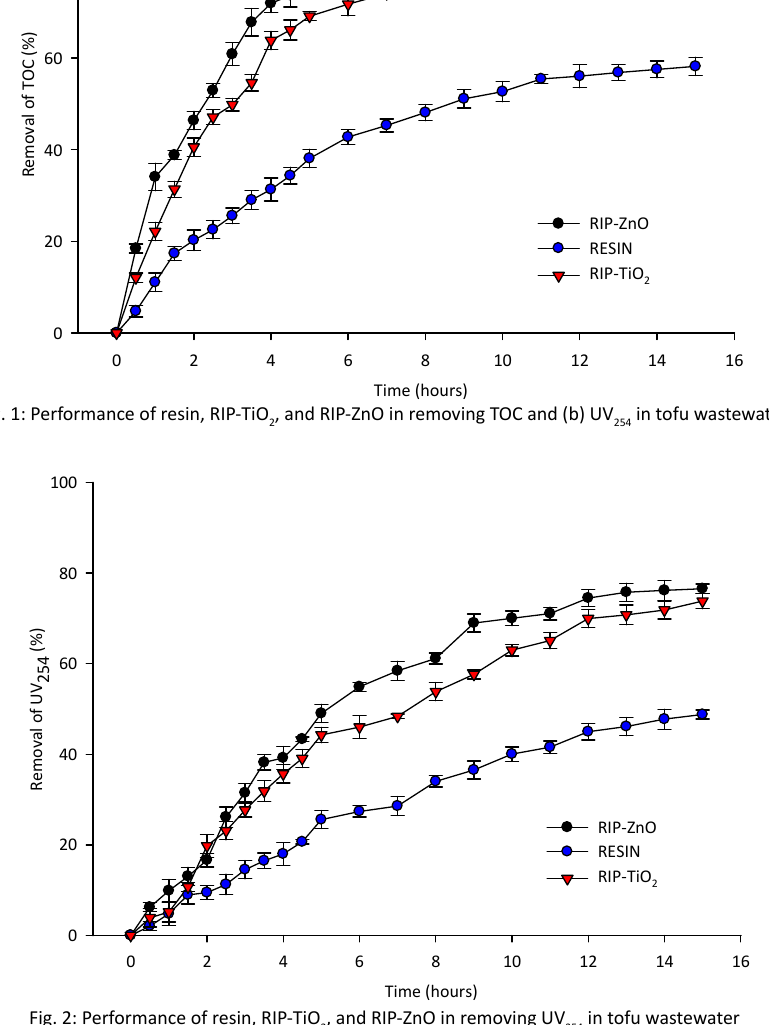
, and RIP-ZnO in removing UV in tofu 2 254